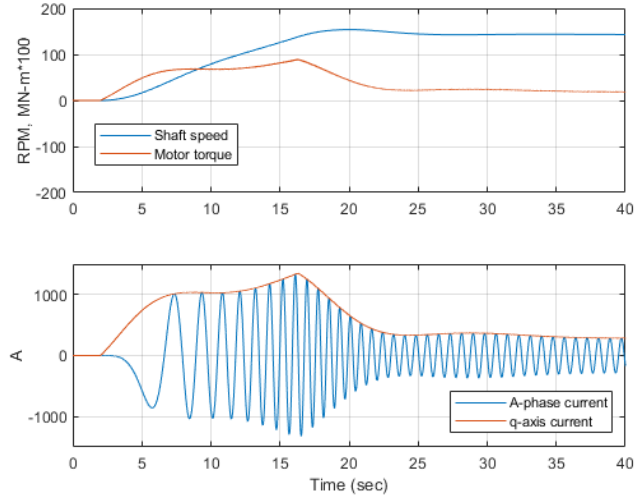
Figure 14. Ahead operation as calculated with the Healy end-to-end model.